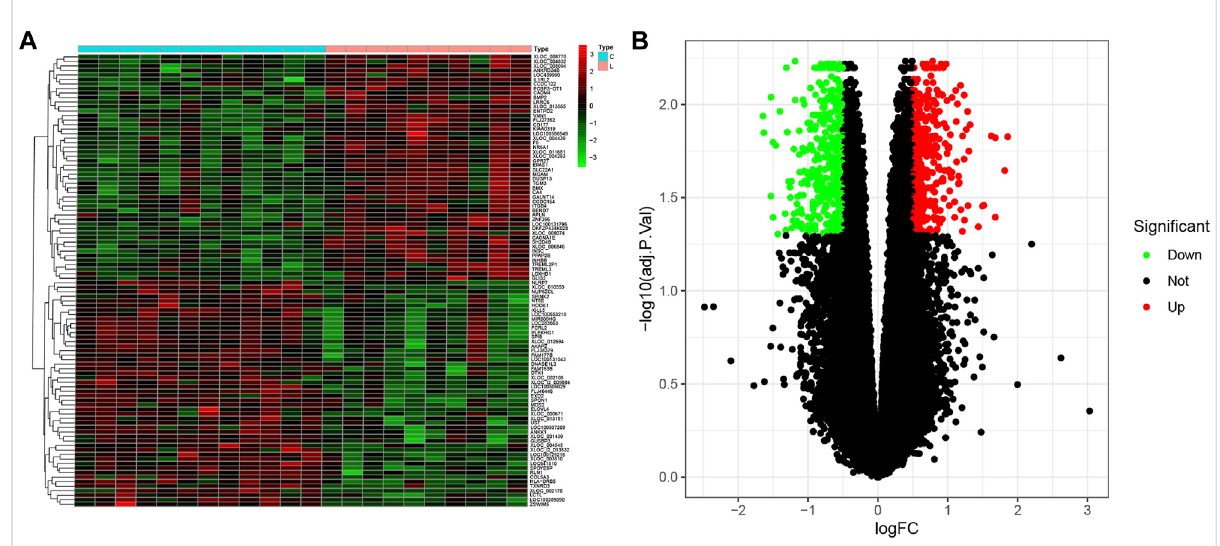
FIGURE 1 Differential expression analysis. (A) Heatmap plot of DEGs of healthy subjects and LOD patients. C, control. LOD, late-onset major depressive disorder. (B) Volcano plot of DEGs. Upregulated and downregulated DEGs are shown in red and green,